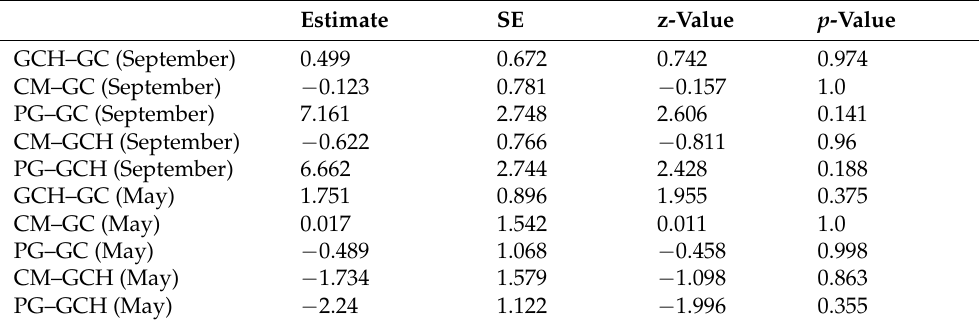
Table A8. Differences in activity densities of agrotopic carabid beetles, comparing grass–clover (GC) and grass–clover herbs (GCH) with each other, and in comparison to conventional maize (CM) and permanent grasslands (PG) in May/June and September.